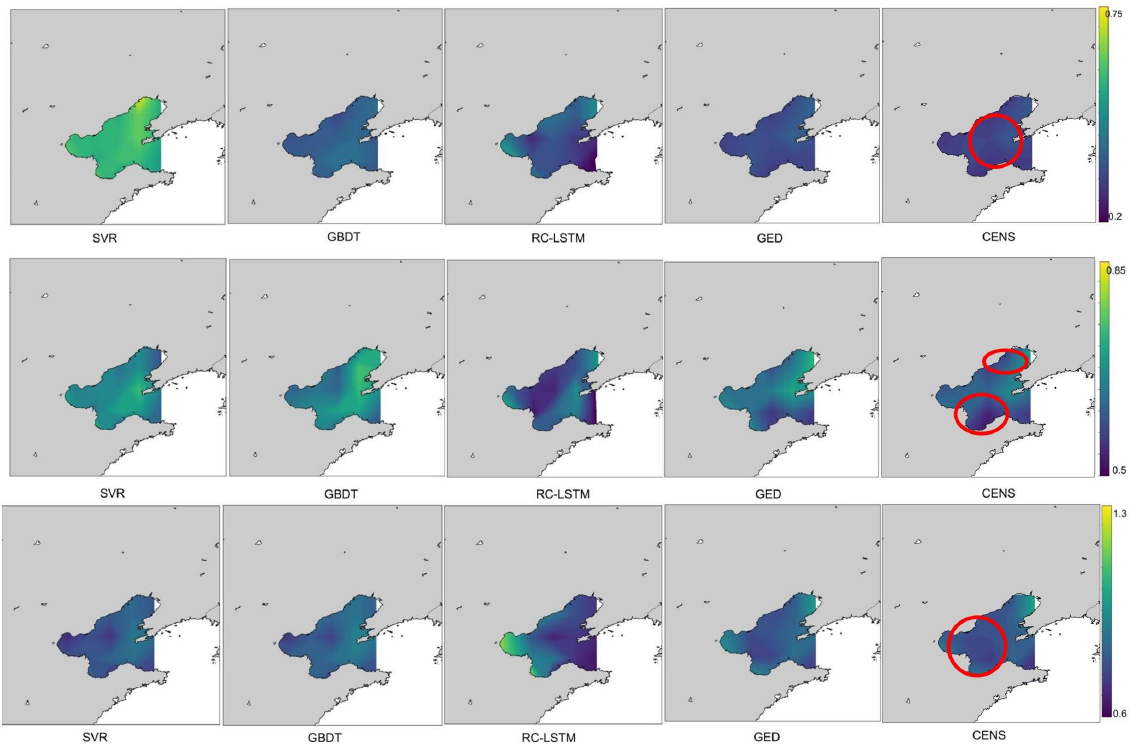
Figure 6. Error distribution in the Bohai Sea for different models in 1, 3, and 7-day sea surface temperature prediction. The error plots of SVR, GBDT, RC-LSTM, GED, and CENS are shown from left to right, and the error results of prediction one day, prediction three days, and prediction seven days are shown from top to bottom. The color bar on the right is the MAE value.